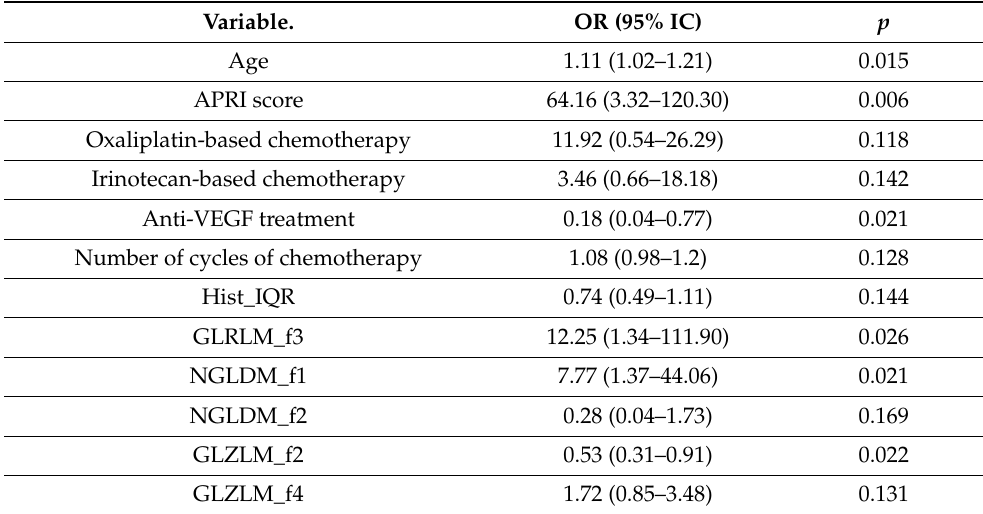
Table 3. Multivariate analysis of predictors of grade 2–3 sinusoidal dilatation.